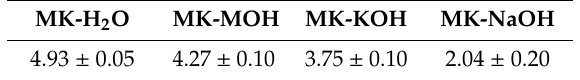
Table 4. Results of weighing the filter residue after dissolution of 5 g MK in different solutions in g.